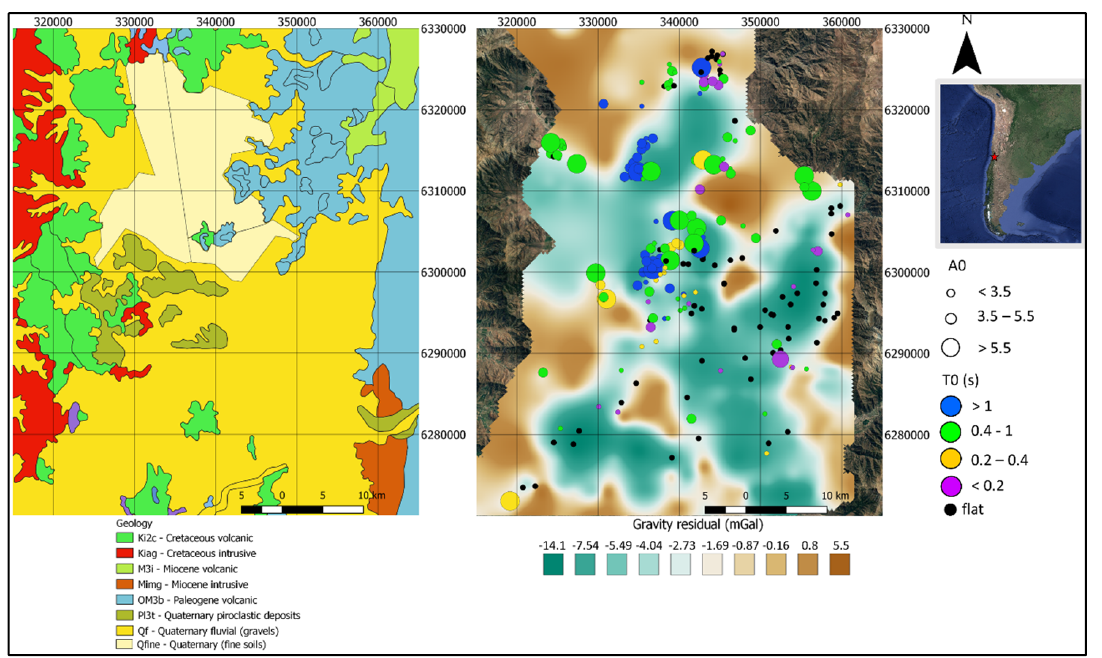
Figure 6. Santiago. Left panel: Simplified geology of the city adapted from Chilean geological map 1:1,000,000 [36]. Right panel: Main results of the geophysical campaign [7,36,39]. The color grid shows the gravity residuals in mGal. The color points show the H/V results. Color indicates the predominant period (T0) in seconds and the size indicates the amplitude (A0) of the H/V curve.